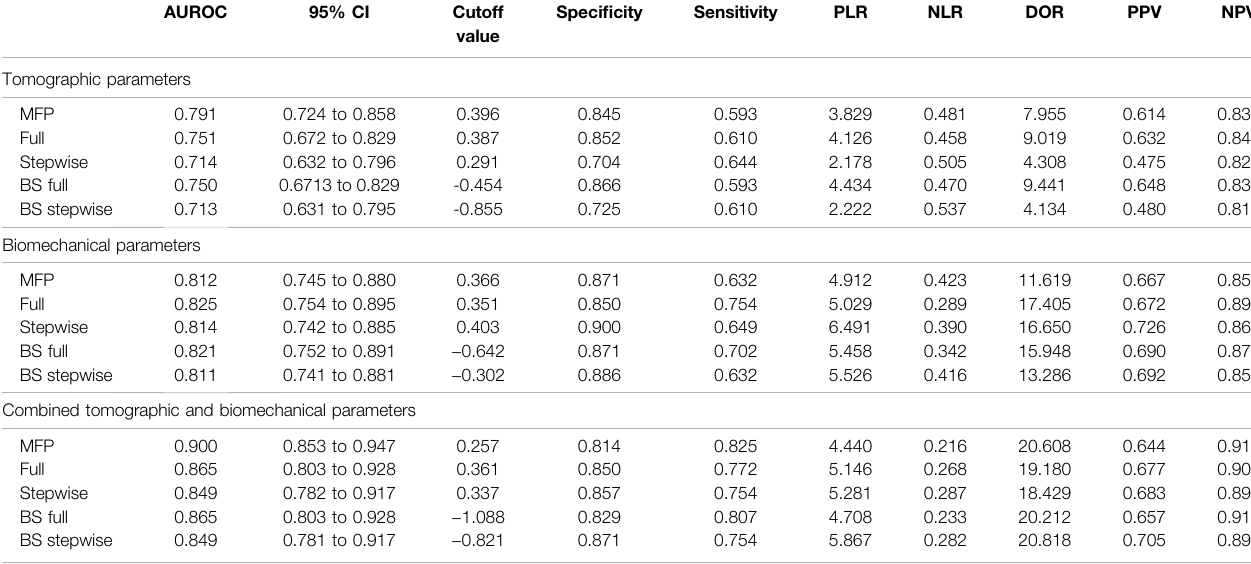
TABLE 2 | ROC curve analysis and optimal threshold analysis for the predictive model between normal and VAE-NT groups for tomographic parameters, biomechanical parameters, and combined tomographic and biomechanical parameters. AUROC